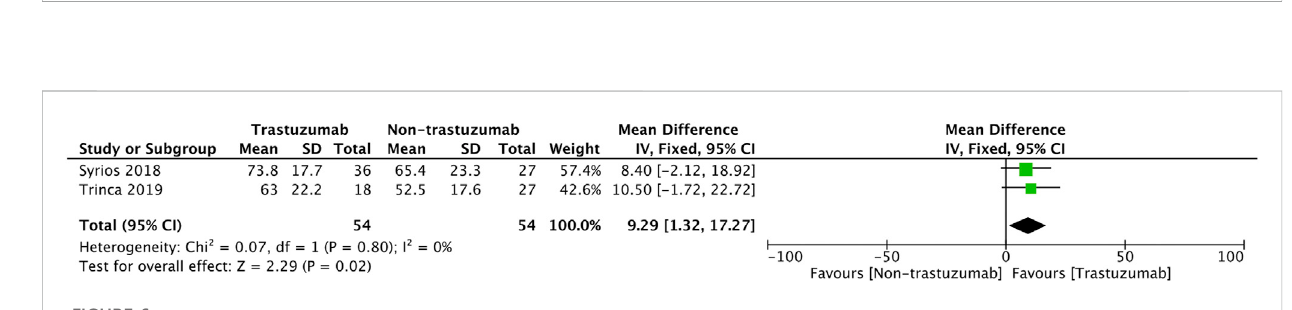
FIGURE 6 Pooled analysis of HRQoL during treatment based on cross-sectional